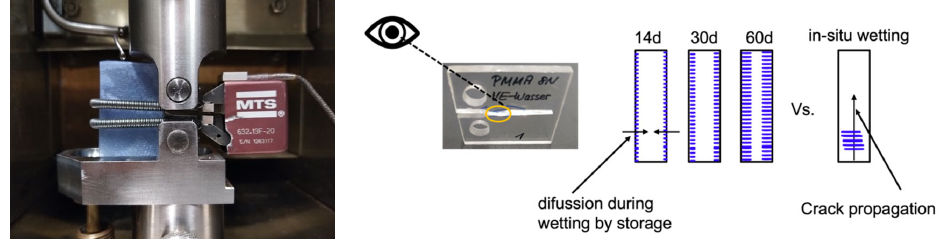
Figure 1. Experimental setup for the ESC measurements under fatigue loading and in situ wetting. Scheme of the SCA diffusion during storage compared to crack propagation. Scheme of the SCA diffusion during storage compared to crack